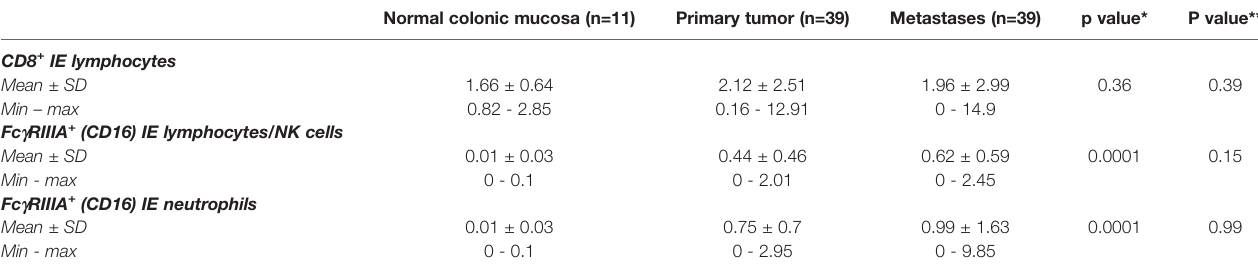
TABLE 3 | Mean percentages of CD8 + and Fc g RIIIA + (CD16) intra-epithelial (IE) cells in normal colonic mucosa, primary tumors and metastases (Mann Whitney test).